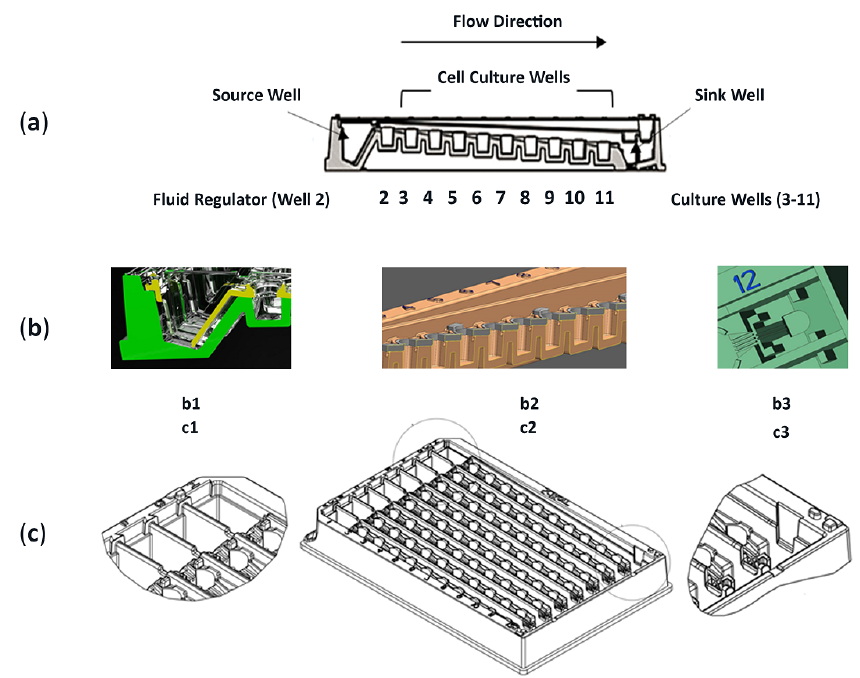
Figure 1. Characteristics of fluidic culture system. ( a ) Profile schematic highlighting source well (well 1), 10 connected compartments (wells 2–11), and sink well (well 12). Wells 2–11 having 0.5 mm decrease in height from each well bottom; total 4 mm height difference. ( b1 ) Profile of source well (well 1) and regulator well (well 2; acellular) allowing nutrient media to flow between assembled components (i.e., yellow and green accents). ( b2 ) Profile of wells 3–11 with polystyrene polymer overlay (grey) covering microfluidic channels. ( b3 ) Top view of sink well (well 12) that is covered by syphon wick (wick not shown). ( c1 ) Top CAD view of source well (well 1). ( c2 ) Top CAD view of fluidics platform. ( c3 ) Top CAD view of sink well (well 12).